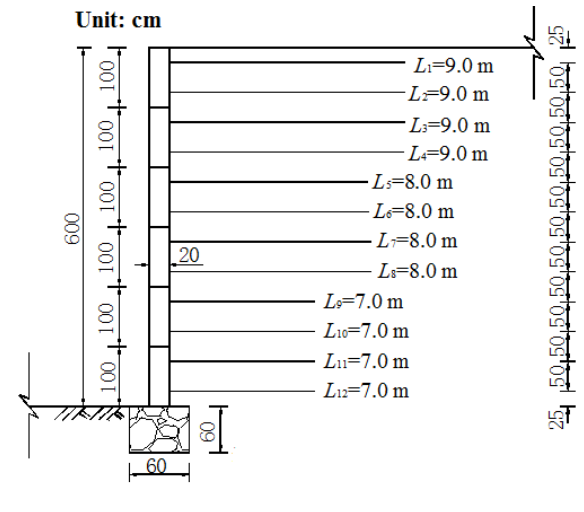
Figure 3. Geometry of the reinforced retaining wall. Table 1. Geometric and geotechnical characteristics of the wall used for the parametric